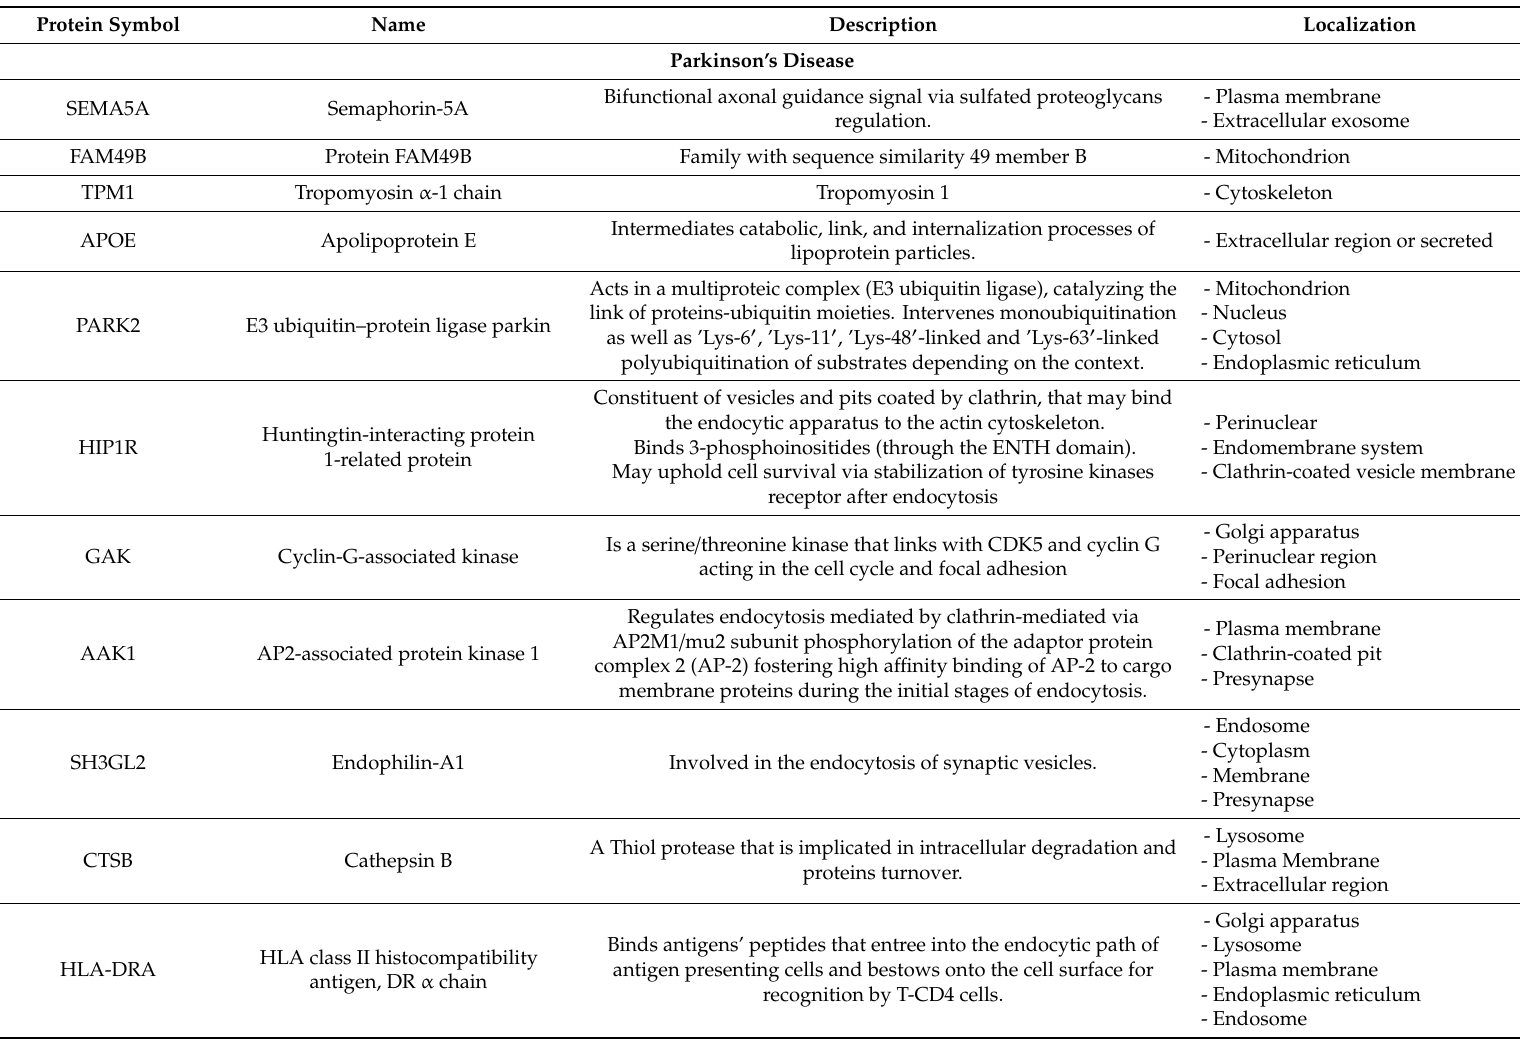
Table 2. Details of the identified proteins in the interaction between PD and